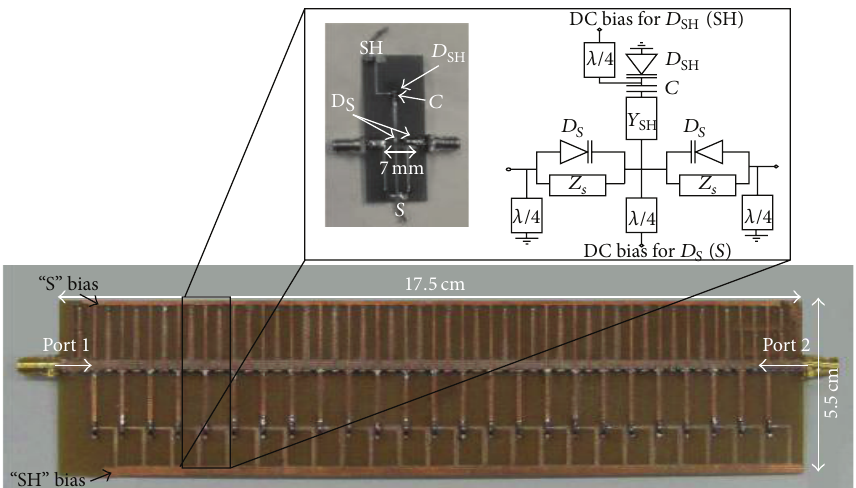
Figure 4: Two-port reconfigurable leaky-wave antenna and its tunable unit cell design (with permission from IEEE).